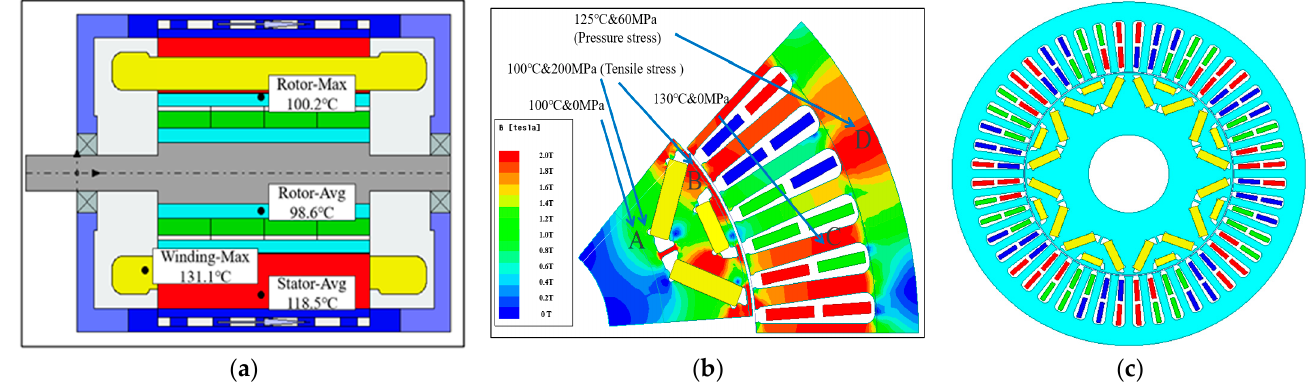
Figure 1. Temperature distribution and magnetic density distribution @ 9000 rpm. ( a ) Temperature rise simulation (flow rate: 15 L/min); ( b ) finite element simulation; ( c ) finite element model.